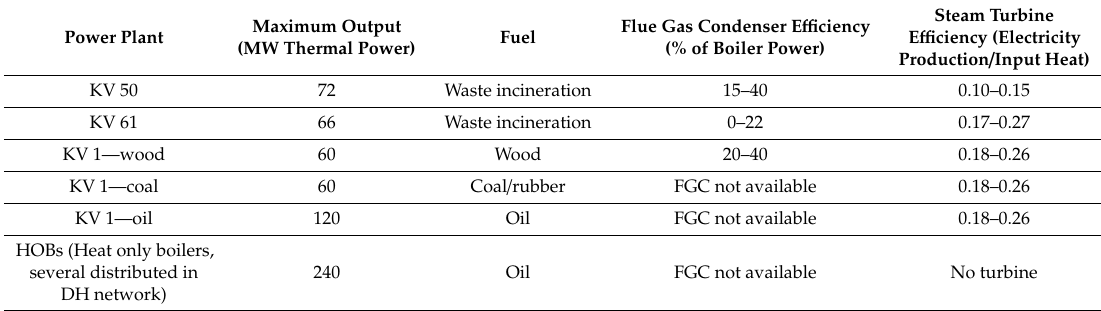
Table 1. Production units in Linköping’s district heating system. FGC—flue gas condenser.